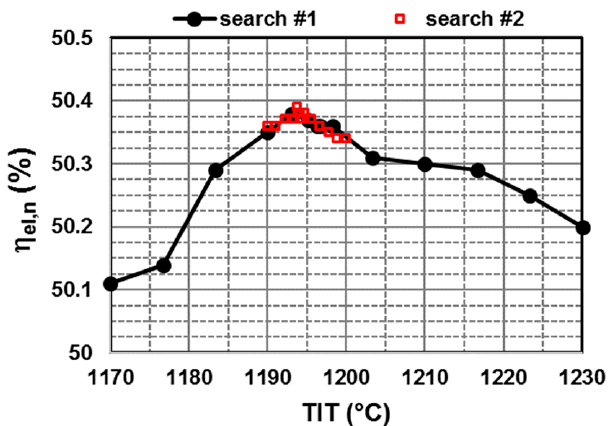
Figure 10. Search process of the maximum net electric efficiency of the Allam cycle as a function of turbine inlet temperature.